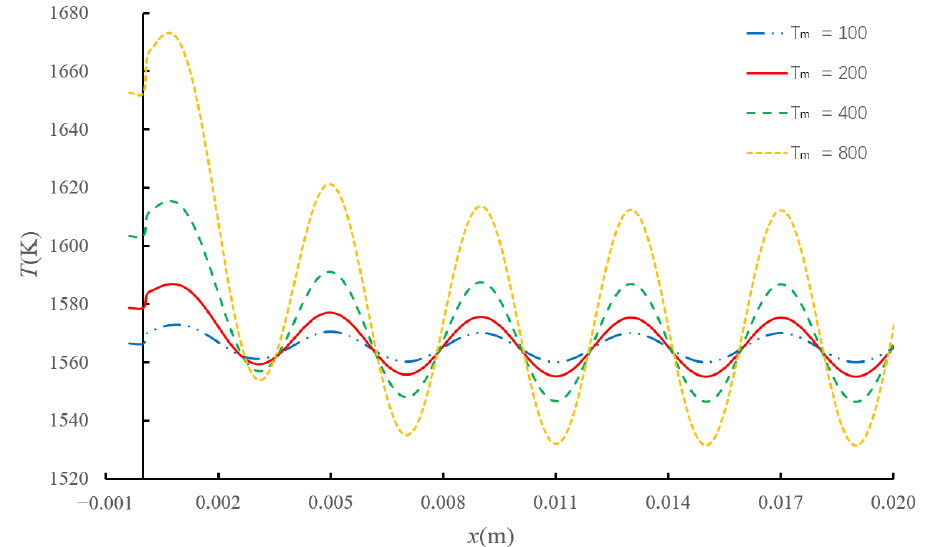
Figure 8. Pt wire temperature profiles with different gas temperature wave